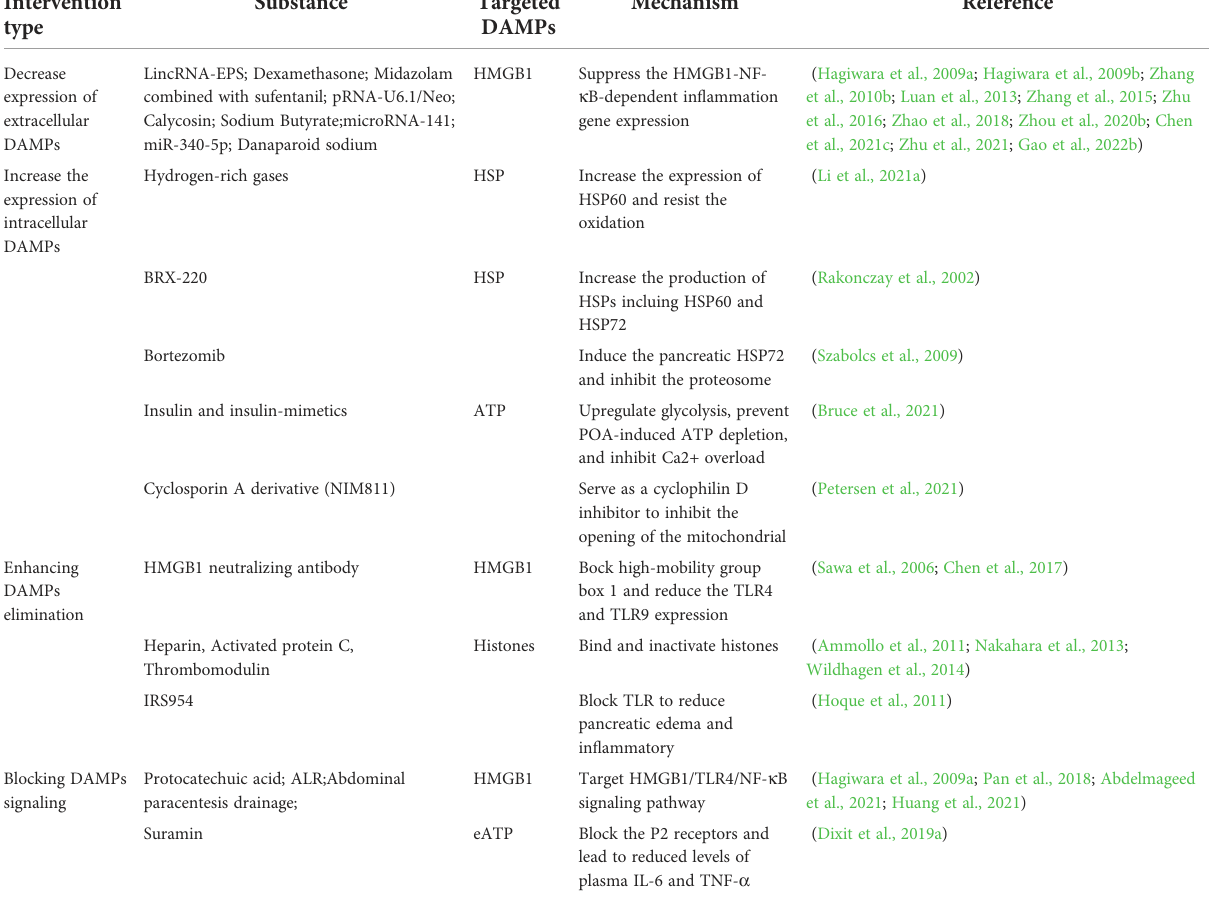
TABLE 2 Intervention of DAMPs in AP therapy, with intervention type, targeted DAMPs and associated